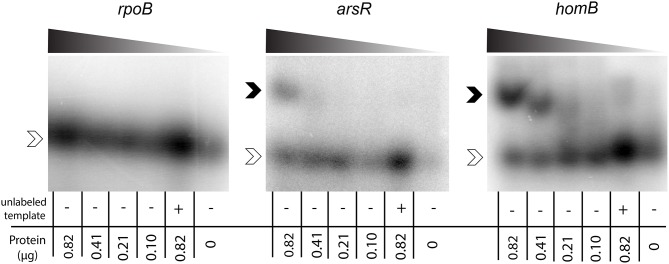
ArsR EMSA. rArsR was purified and phosphorylated in vitro. Binding to the rpoB promoter (negative control), arsR promoter (positive control), and homB promoter were assessed. Protein was loaded in decreasing concentrations from left to right across the gel (0.82–0.10 μg) and is represented by the shaded wedge above each gel. A competition reaction with 2x unlabeled template and 0.82 μg protein was run in the lane second from the right of each gel and a no protein control was run in the right most lane. Open arrowheads indicate unbound DNA template, and filled arrowheads indicate DNA template bound to rArsR~P.